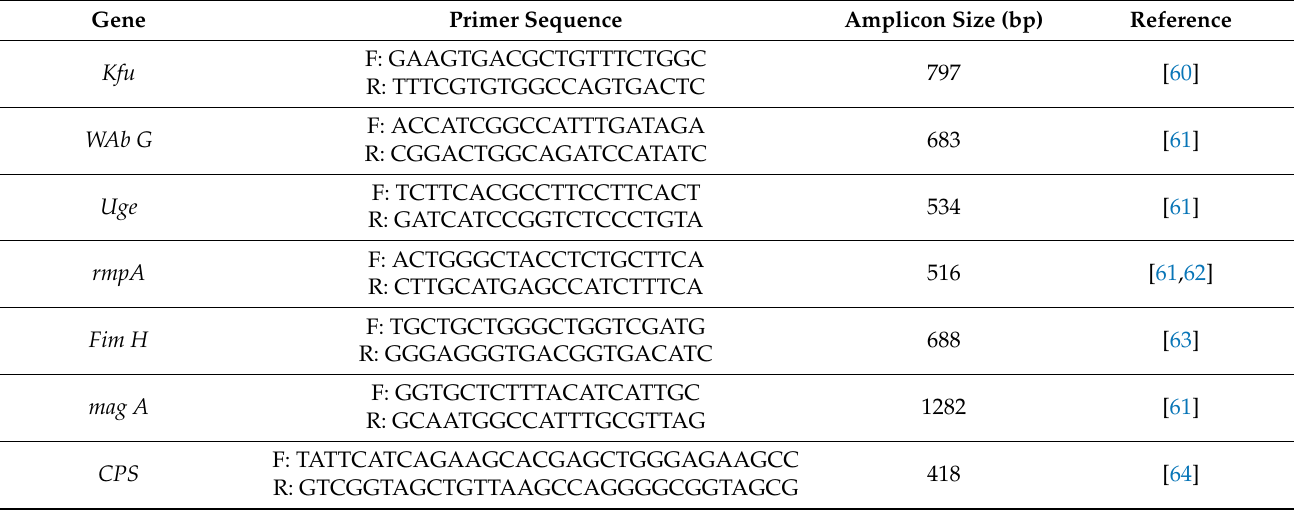
Table 9. Primer sequence and amplicon sizes (bp) for detecting virulence genes in K. pneumoniae isolates.